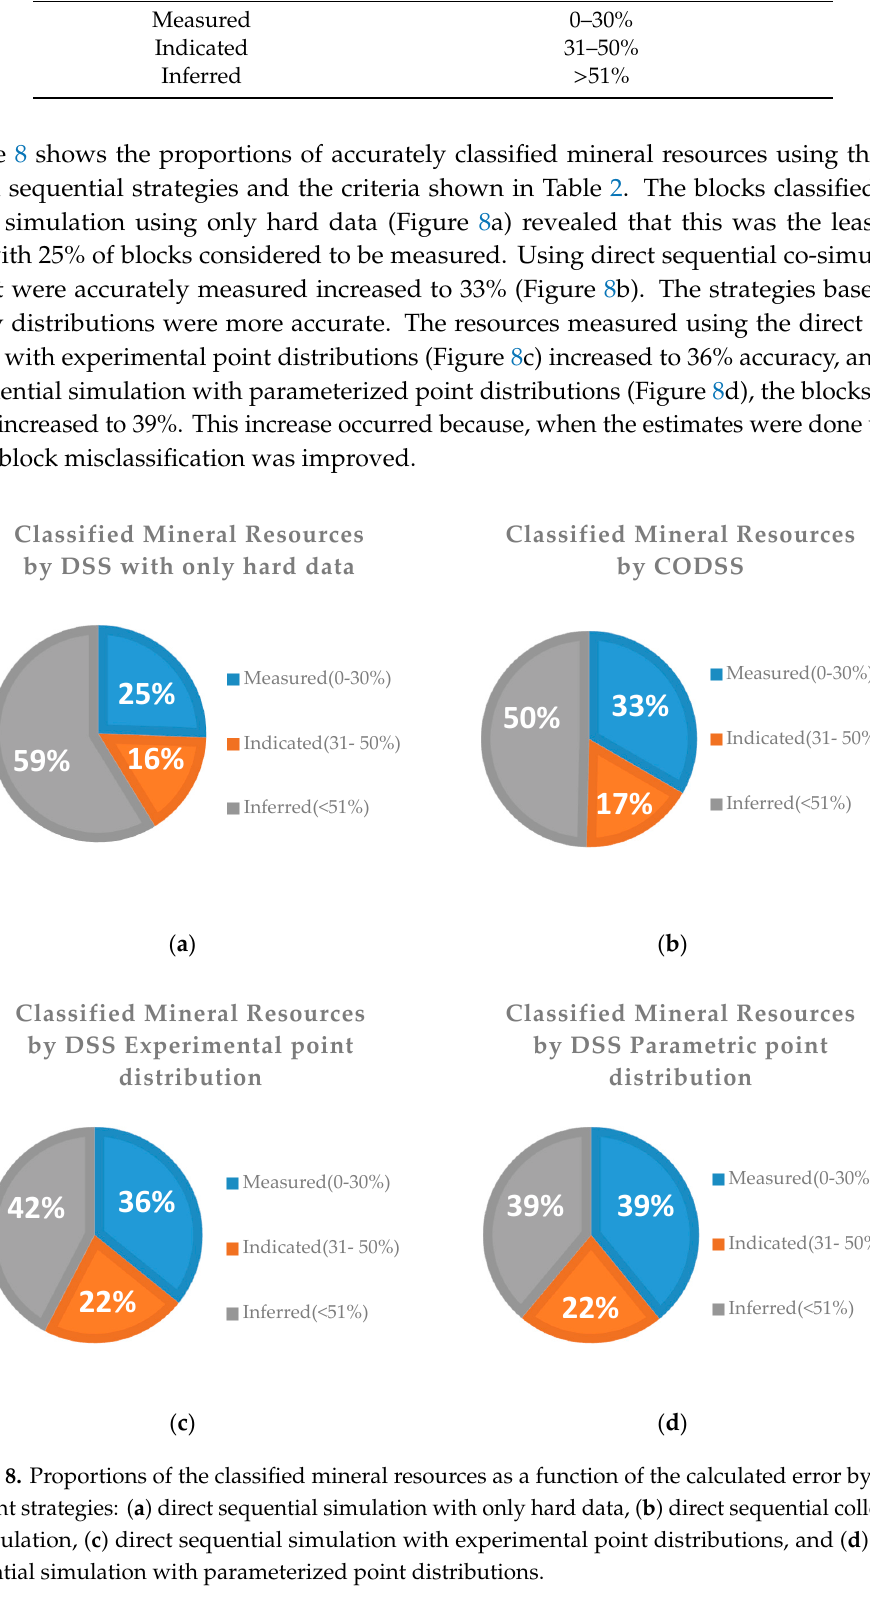
Table 2. Proportions of the accurately classified mineral resources as a function of calculated relative error.